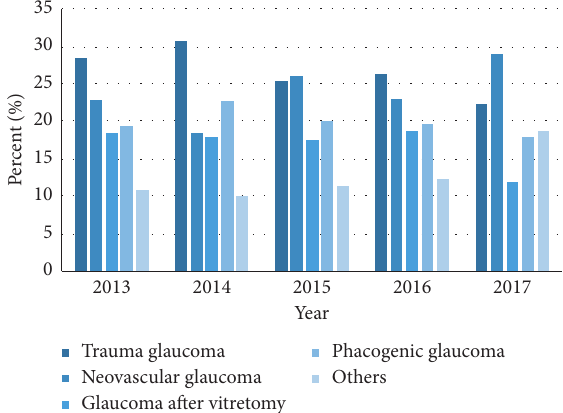
Figure 3: Annual distribution of the different types of secondary